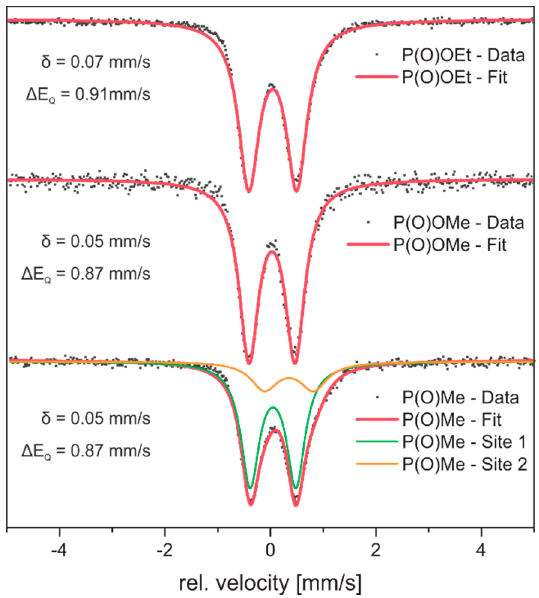
Figure 7. Room temperature zero field Mössbauer spectra of compounds 12-OEt , 12-OMe and 12-Me . Table 2. Mössbauer parameter of compounds 12-R compared to different known model complexes.